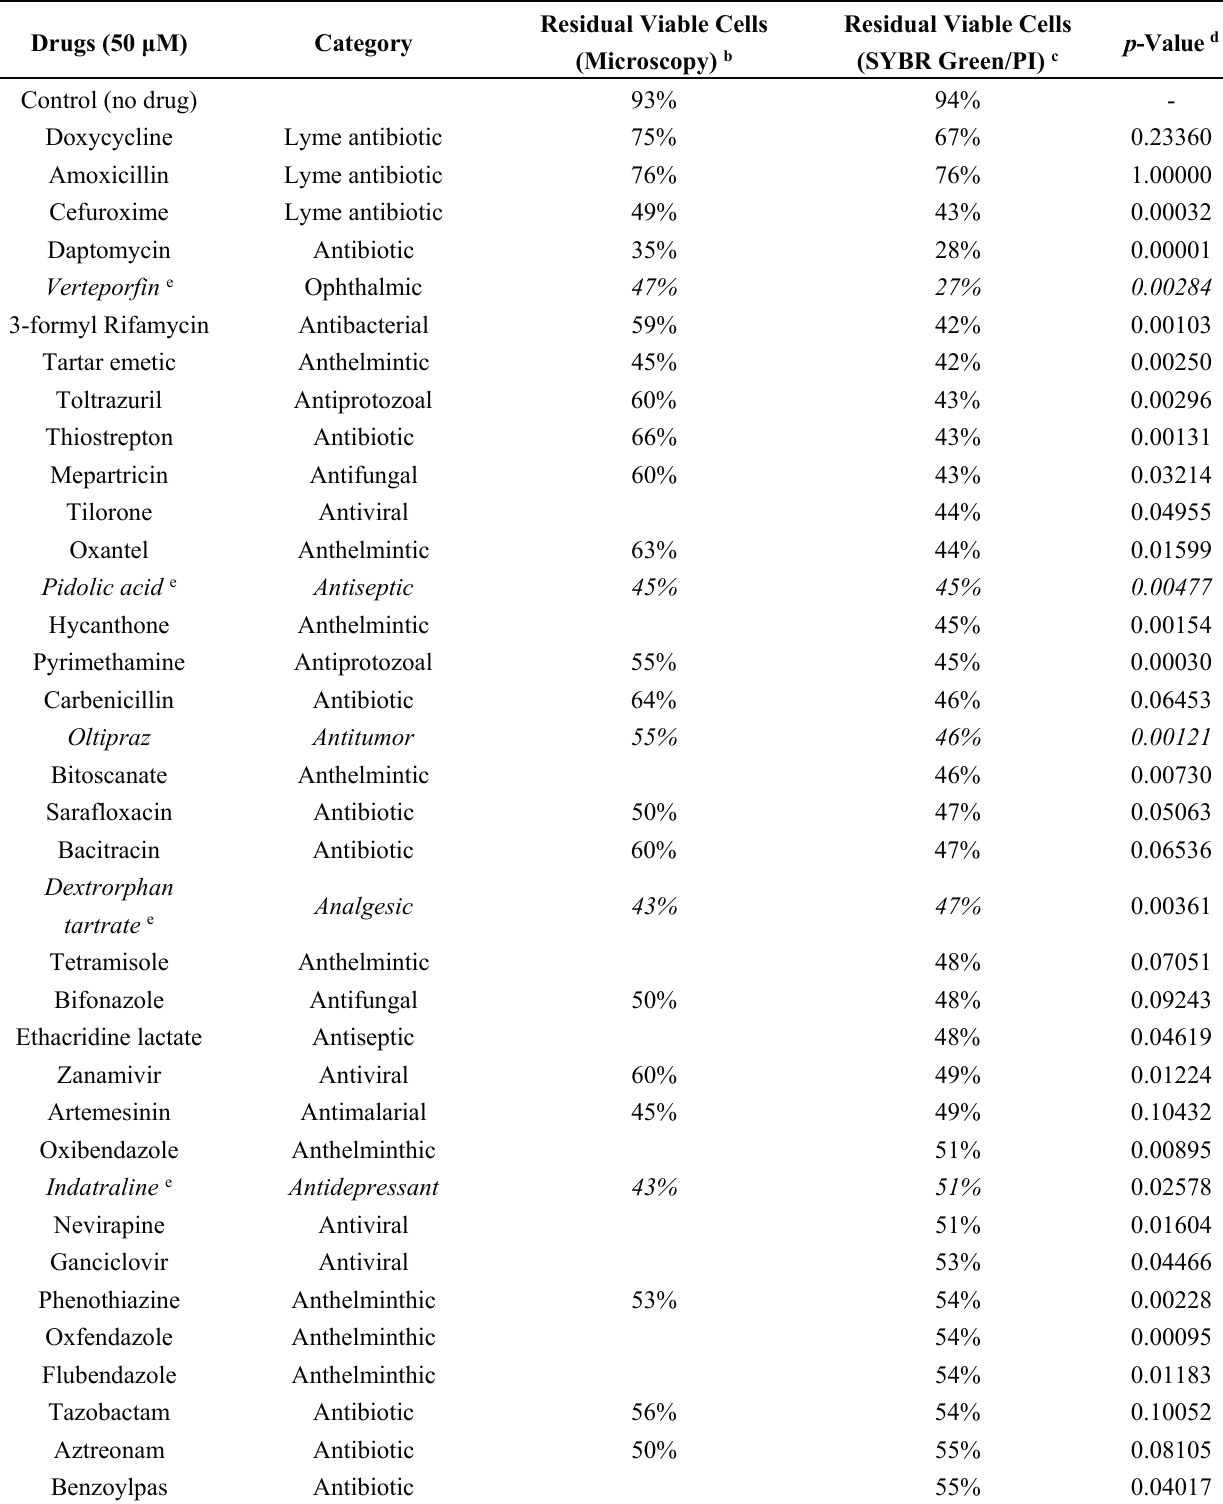
Table 1. Top 52 active hits with better activity ( p -value < 0.05 or live percentage by microscopy assay less than 68%) against B. burgdorferi stationary phase cells than current Lyme antibiotics a